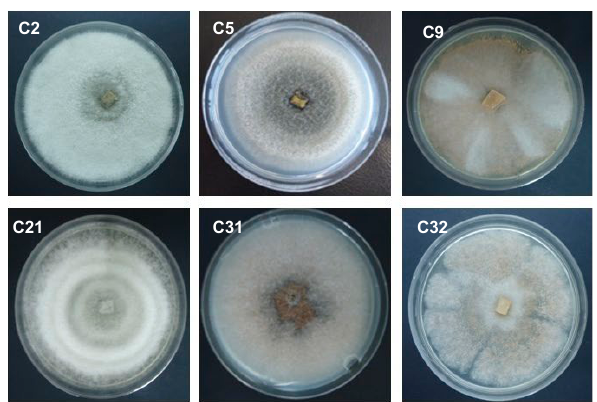
Figure 4. Morphology of Colletotrichum gloeosporioides isolates C2, C5, C9, C21, C31 and C32 on PDA plates incubated at 25 °C for 7 d.